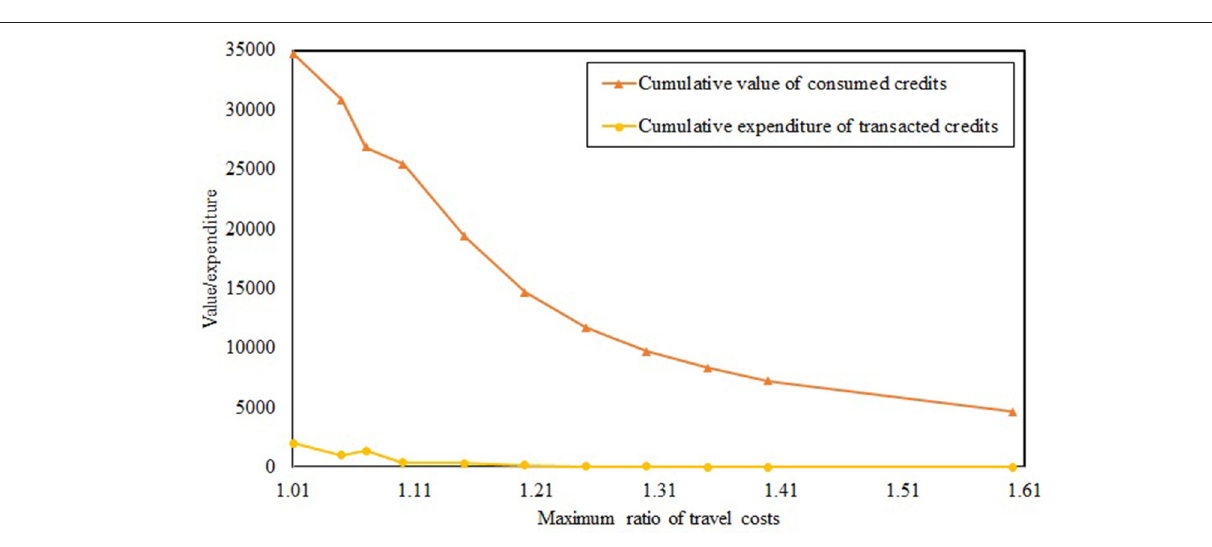
FIGURE 8 | Cumulative value of consumed credits and cumulative expenditure of transacted credits under different maximum ratios of the travel